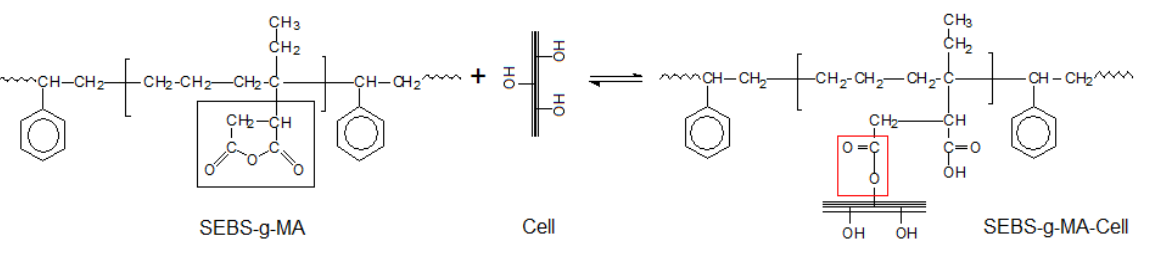
Figure 10. Reaction scheme of SEBS-g-MA and